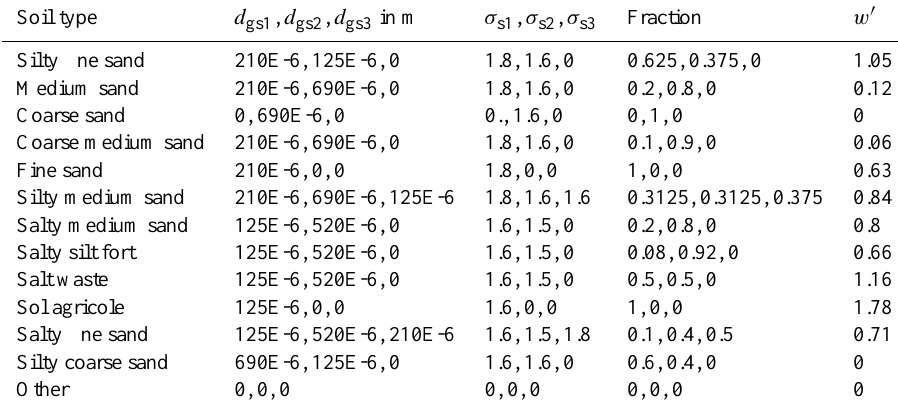
Table 1. Classification of 13 different sand types. Each type contains information of up to three size distributions of particles including the median diameter ( d gs ) , the standard deviation ( σ s ) , and the fraction of erodible surface (fraction) (Chatenet et al., 1996). Additionally information about the residual soil moisture content ( w 0 ) is given (F´ecan et al.,